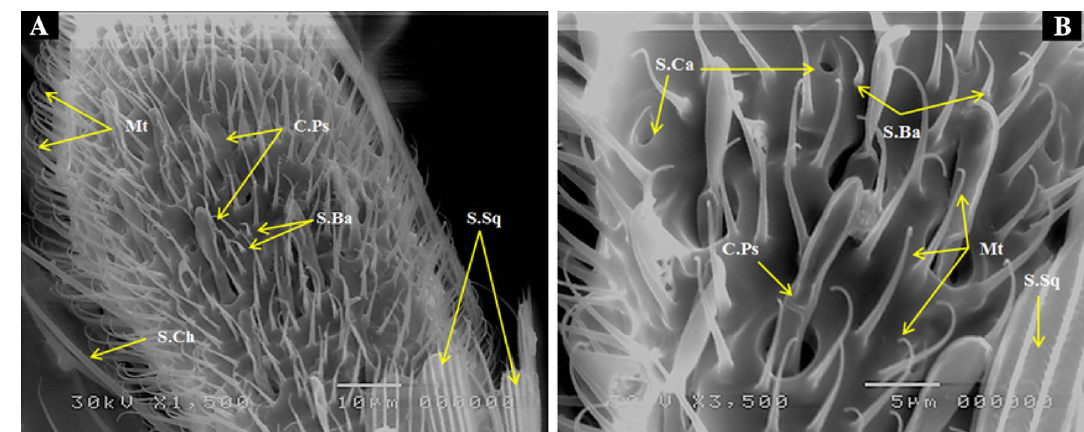
Figure 3. SEM photography of control, Culex pipiens female 4th distal end of maxillary palp (1500 and 3500×) showing ( A ) densely covered with the microtrichia (Mt), individual olfactory capitate peg sensilla (C.Ps), sensilla basiconica (S.Ba), sensilla chaetica (S.Ch) and sensilla squamiformia (S.Sq). ( B ) Showing stress sense organs sensilla campaniformia (S.Ca) at higher